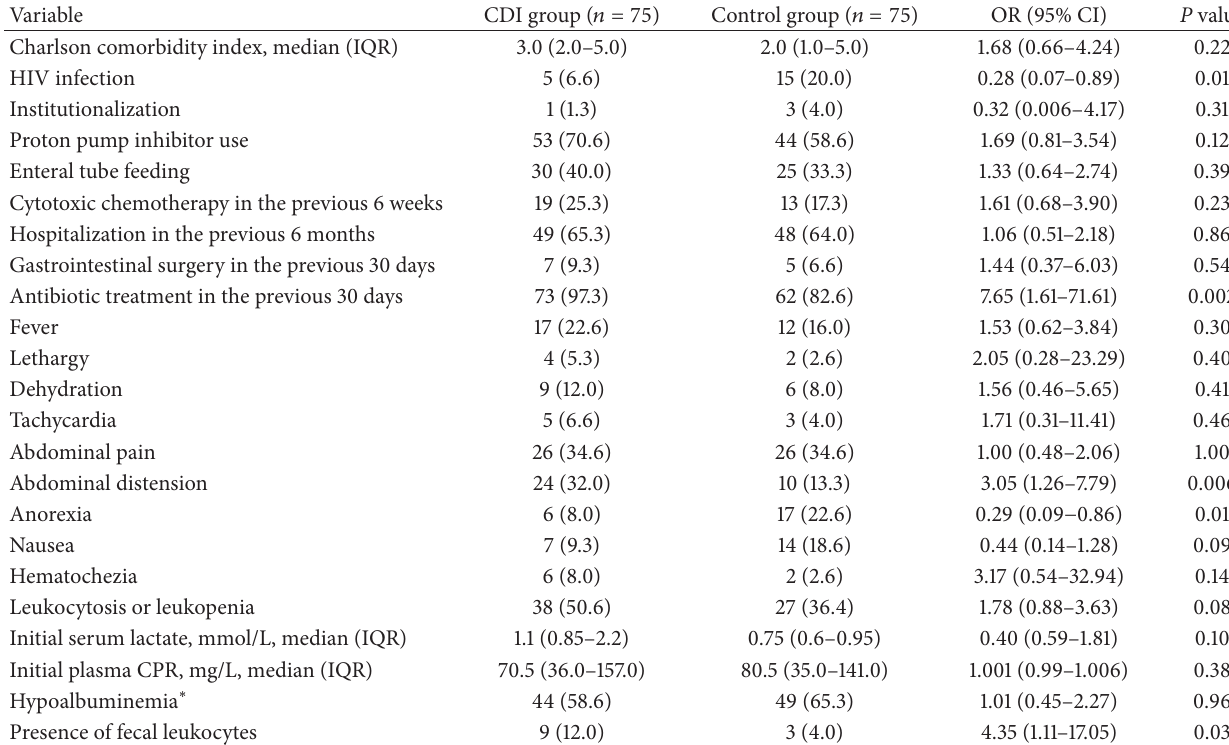
Table2:Factorsassociatedwith Clostridiumdifficile infectioninadultpatientswithhospital-acquireddiarrheaaccordingtounivariatelogistic